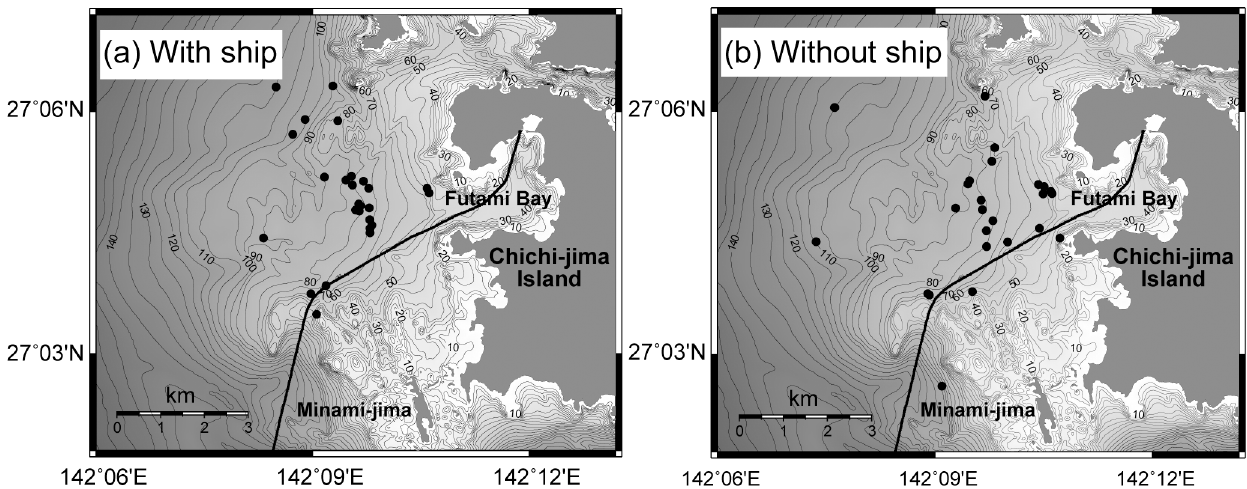
PLOS ONE | https://doi.org/10.1371/journal.pone.0204112 October 24,